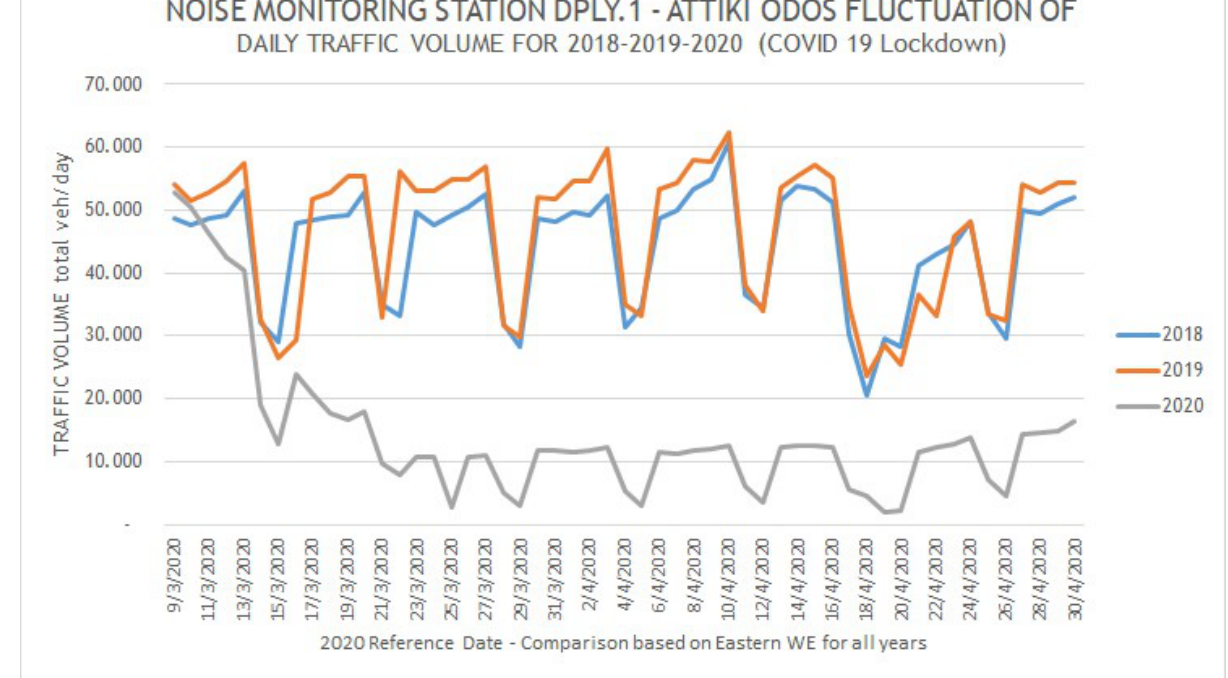
Figure 8g: Daily traflc volume – Noise monitoring station DPLY.1